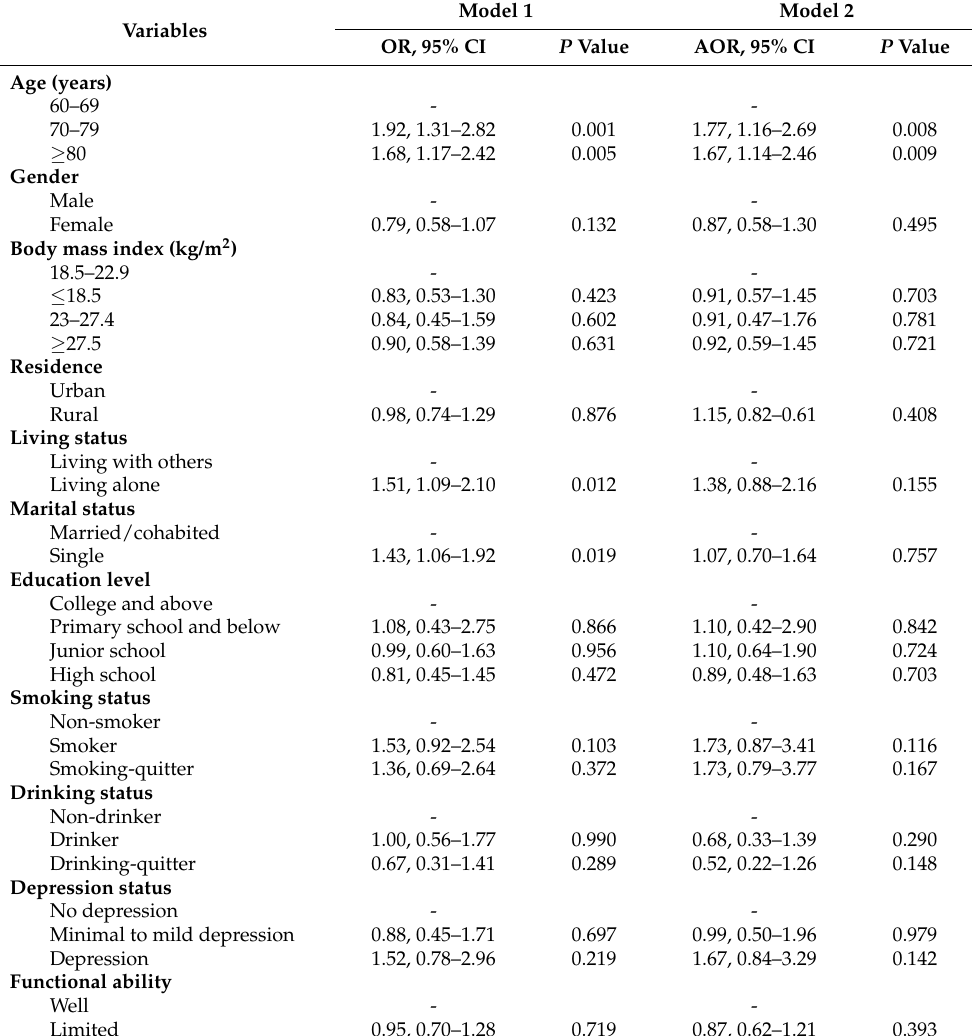
Table 3. Logistic regression analysis examining the correlation of medication adherence in frail older adults ( n =